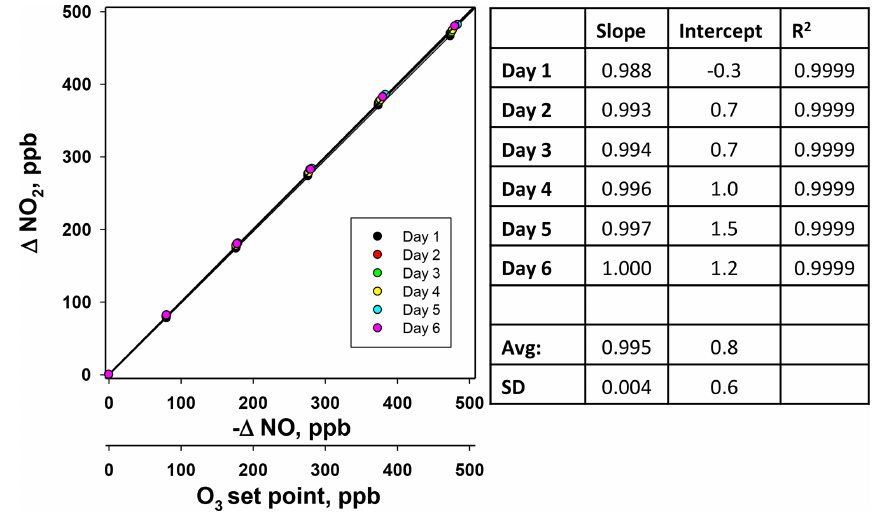
Figure 11. Calibration curves for NO 2 made on six consecutive days. (cid:49) NO 2 =NO 2 − NO 2 ( O 3 =0 ) and - (cid:49) NO=NO ( O 3 =0 ) – NO at each ozone set point. Slopes, intercepts, and correlation coefficients are reported in the panel to the